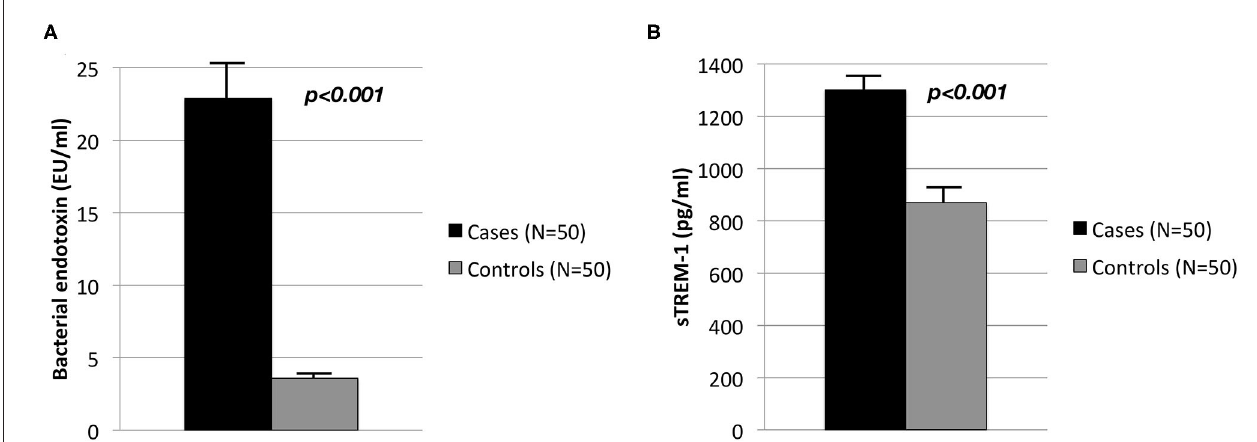
FIGURE 1 | Circulating levels in controls ( N = 50) and cases ( N = 50) of (A) bacterial endotoxin (EU/ml) and (B) sTREM-1 (pg/ml).